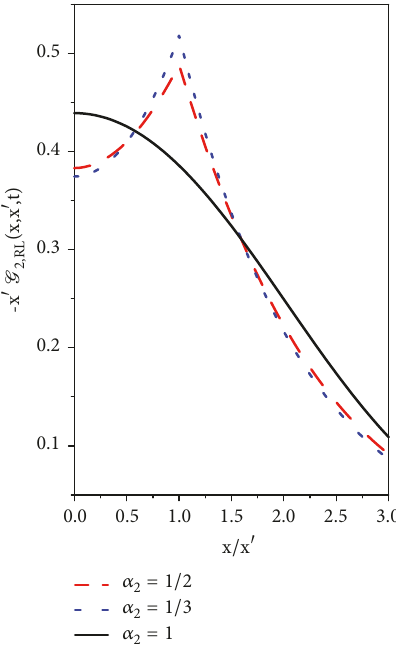
Figure 5: This figure illustrates the behavior of (31) by consid- ering different values of 𝛼 2 . We consider, for simplicity, 𝜏 2,𝑅𝐿 = (𝑥 󸀠2 / K ) 1/𝛼 2 , 𝑘𝜏 /𝑥 󸀠 = 1 , and 𝑡 = 𝜏 2 2,𝑅𝐿 𝑅𝐿,2 , in arbitrary